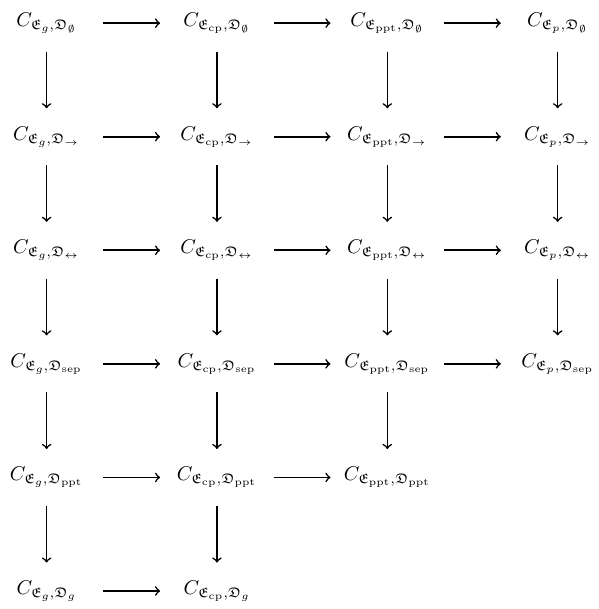
FIG. 3. The relation hierarchy for the dense coding capacities C E , D ((cid:2) AF ) investigated in this paper, where x → y means that x ≤ y in the hierarchy.